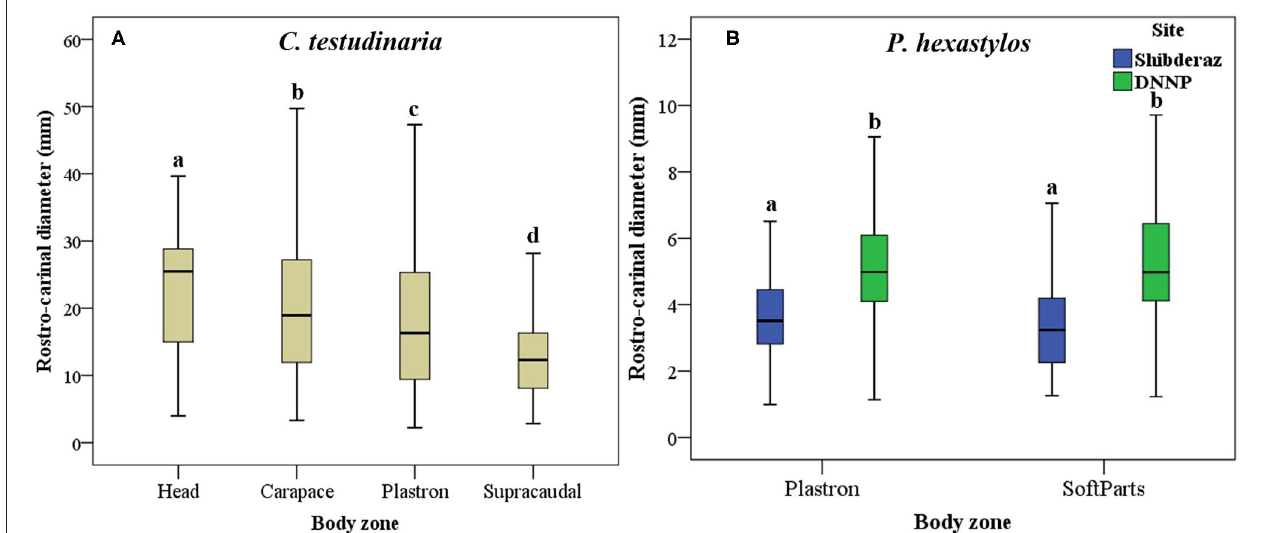
FIGURE 5 | Box plot showing Rostro-Carinal Diameter (RCD) of the turtle barnacles on different body parts of hawksbill turtles ( E. imbricata ) in Shibderaz and Dayyer-Nakhiloo National Park (DNNP): (A) Chelonibia testudinaria on head, carapace, plastron, and supracaudal and, (B) Platylepas hexastylos on plastron and soft parts.